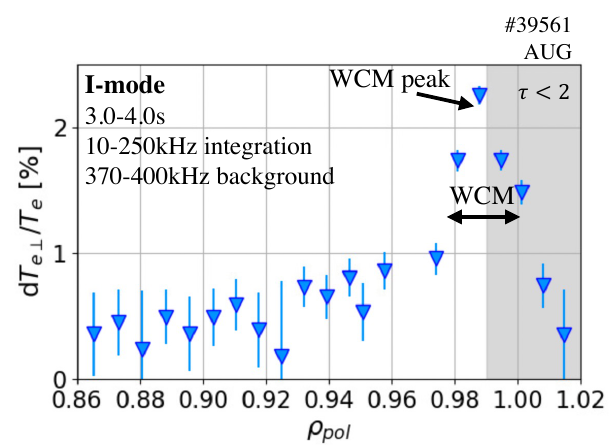
Figure 1. Electron temperature fluctuation level over radius for an I-mode phase of a discharge. The turbulence integration win- dow was 10-250 kHz and the background subtraction window was 370-400 kHz in the calculation of fluctuation amplitude. The region of marginal optical depth τ < 2 are shaded in grey. Fluc- tuation levels rise from ∼ 0 . 5% in the outer core to 2 . 3% at the WCM peak near ρ pol = 0 . 99.